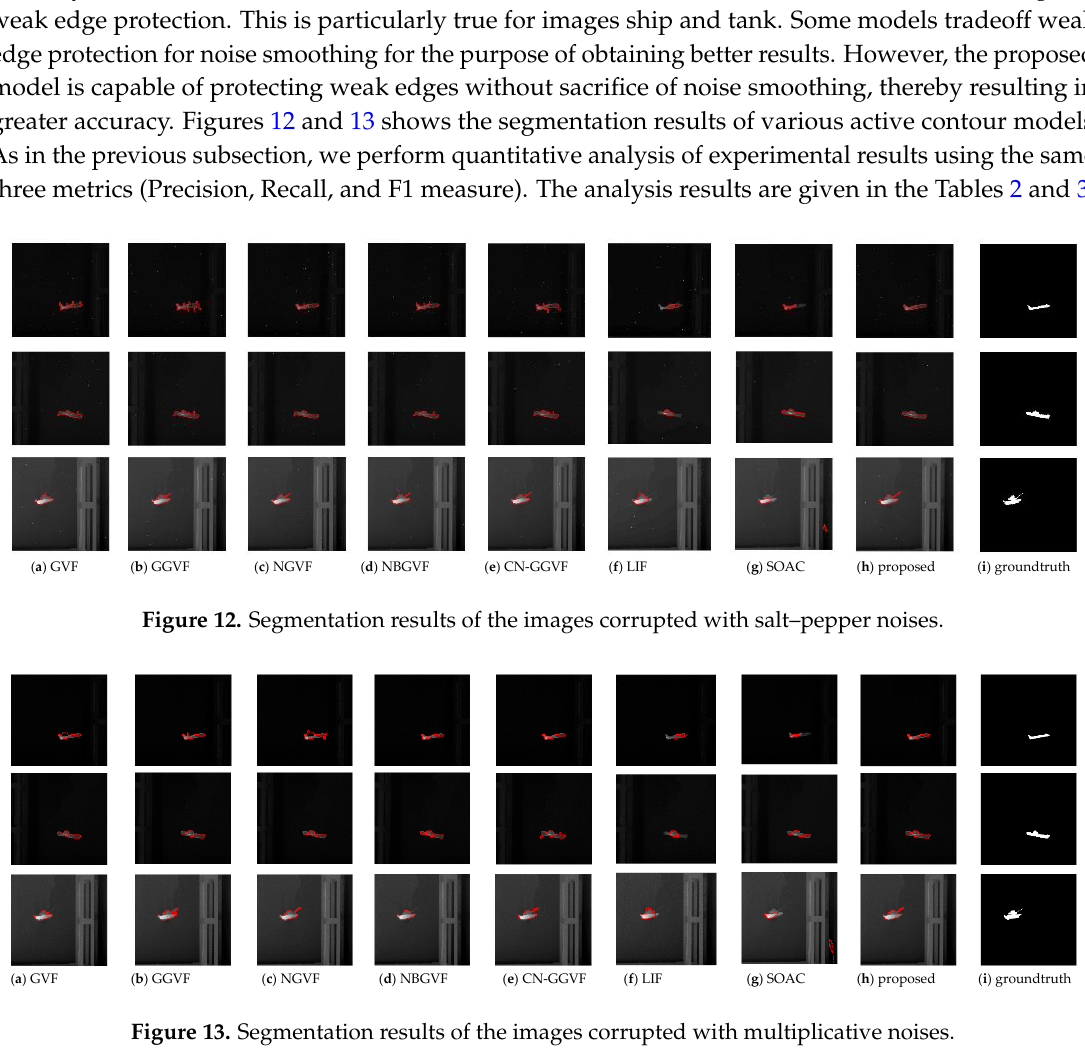
Figure 13. Segmentation results of the images corrupted with multiplicative noises. Table 2. The comparison of Quantitative evaluation results on infrared images corrupted with salt–pepper noise.